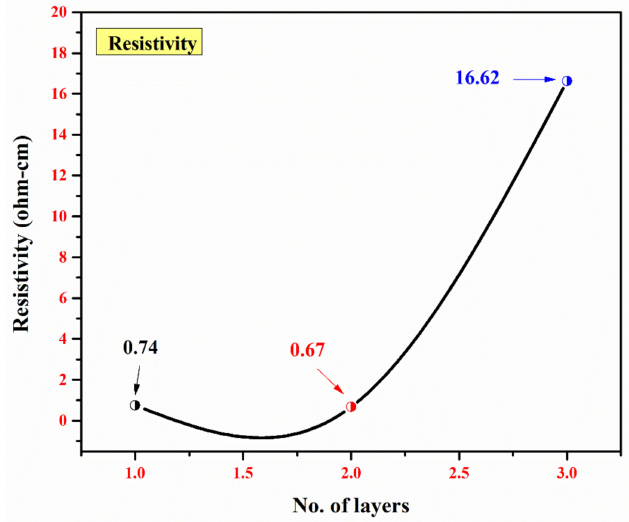
Figure 5. A plot of the no. of layers vs. resistivity ( Ω -cm) for a single layer of TiO 2 , a bi-layer of TiO 2 /V 2 O 5 , and a multi-layer of TiO 2 /V 2 O 5 /TiO 2